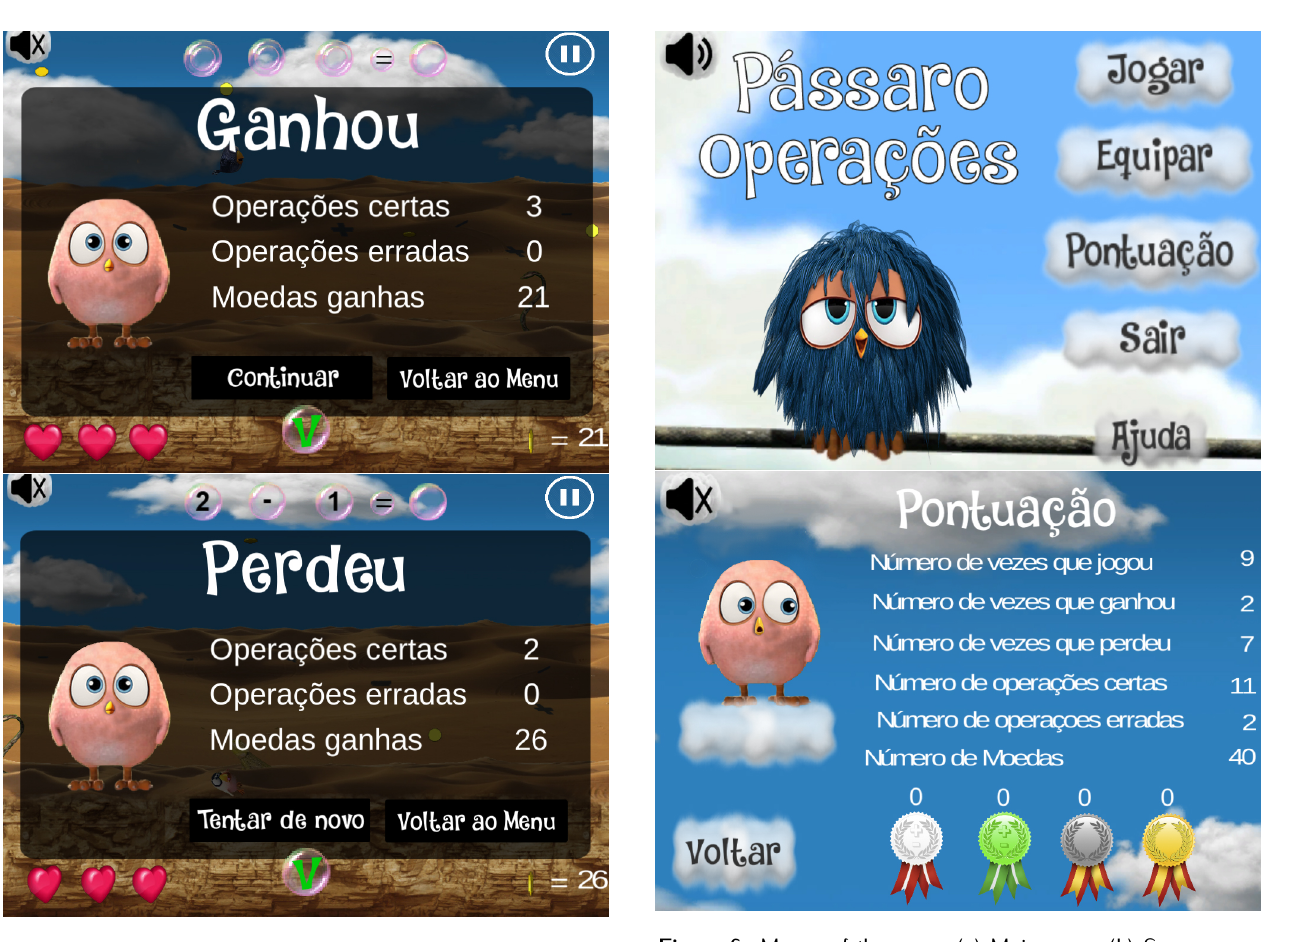
Figure 5. Screenshots of feedback to the player. (a) When the player win. (b) When the player loses.